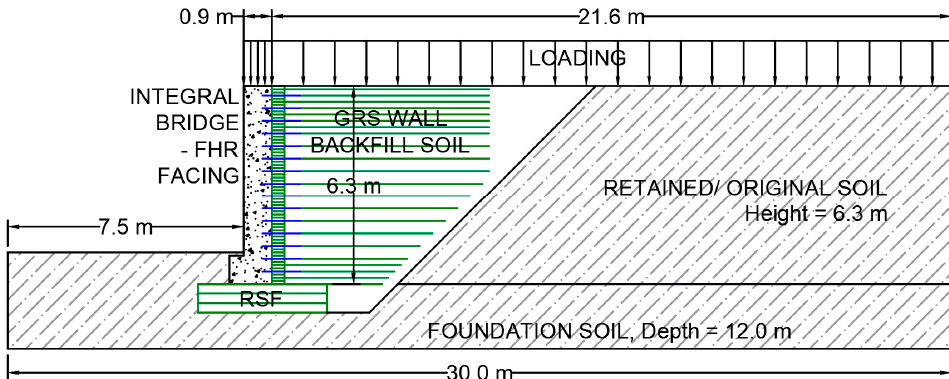
Figure 4. Plaxis 2D numerical model configuration for GRS-IB (Case 1).